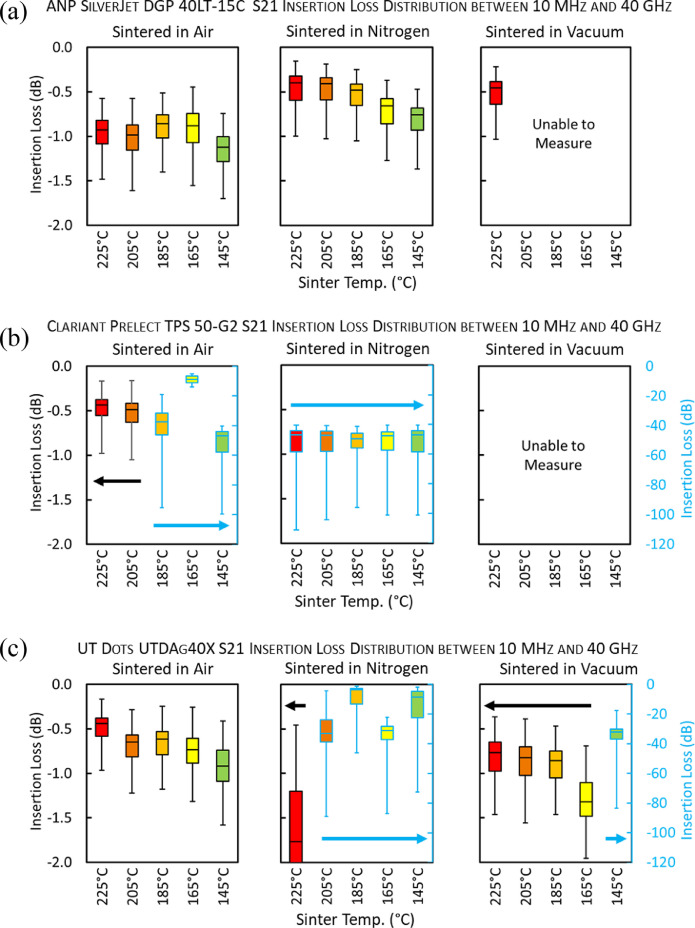
Boxplots which graphically summarize the insertion loss distribution over the 10 MHz to 40 GHz range for each of the inks sintered under each condition is shown. This graphing method depicts five key points for each sintering condition; the minimum value, the first quartile value, the mean value, the third quartile value, and the maximum value. A secondary y-axis (blue) is added to (b) and (c) to more clearly present the insertion loss distribution over two distinct regimes. Some CPWs scratched easily or delaminated when probed for RF interrogation; these were labeled as “unable to measure”.